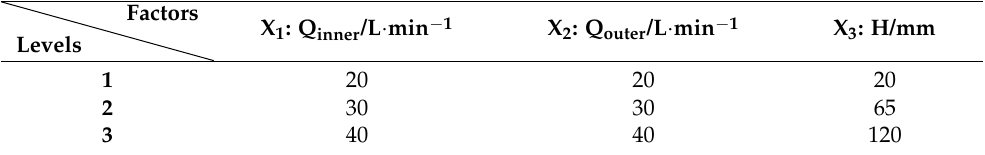
Table 2. Factors and levels used in the orthogonal experimental design L9 (3 4 ).